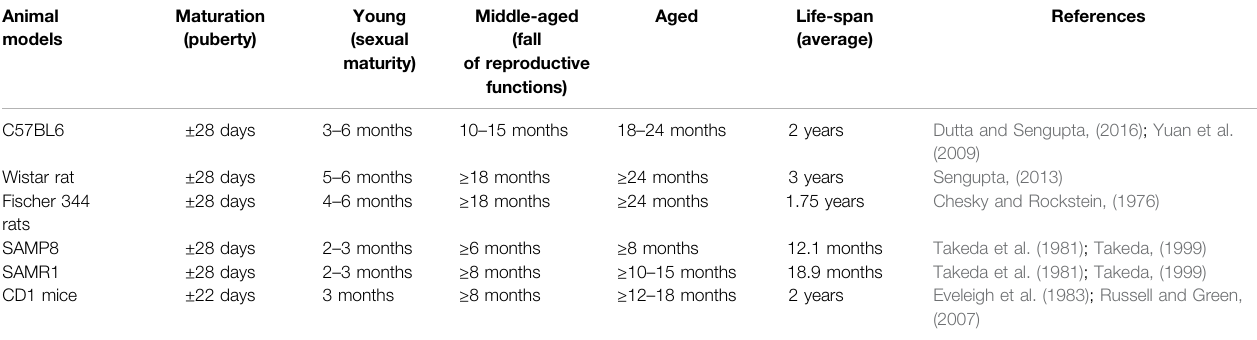
TABLE 2 | Non genetically-modi fi ed mouse models regularly used in aging research and their relative ages of study in males and females. Animal